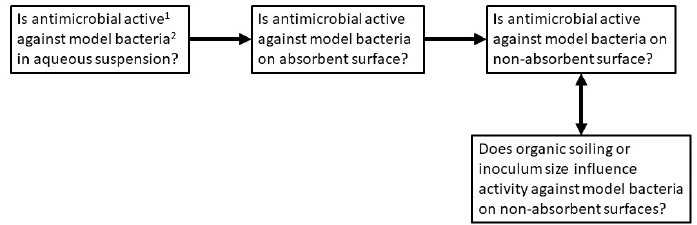
Figure 1. Experimental strategy. Polyaniline (PANI) and functionalised derivative (fPANI) are tested according to the scheme presented. 1 Activity is measured as reduction in the number of viable cells recovered from surfaces. 2 The Gram positive bacterium S. aureus , and the Gram-negative bacterium E. coli were tested as model species.